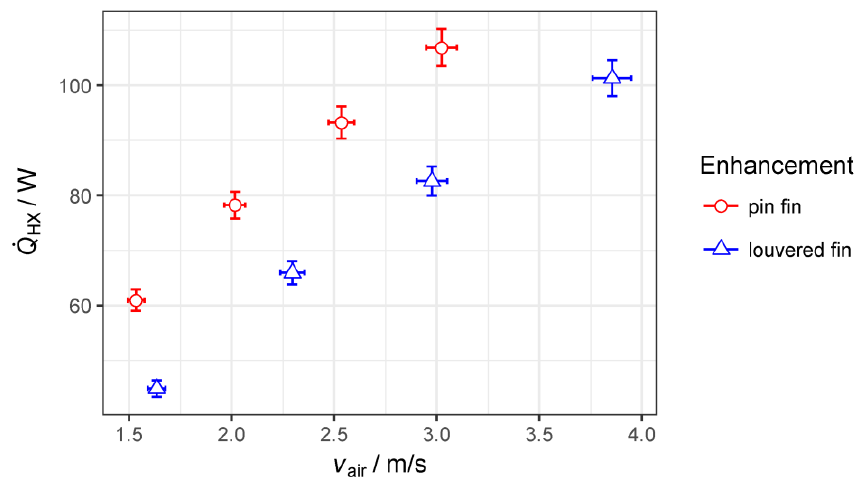
. Q HX versus air velocity v air for louvered and pin fins; error bars for Figure 8. Heat flow rate Figure 8. Heat flow rate 𝑄̇ HX versus air velocity 𝑣 air for louvered and pin fins; error bars for expanded uncertainty. expanded uncertainty.